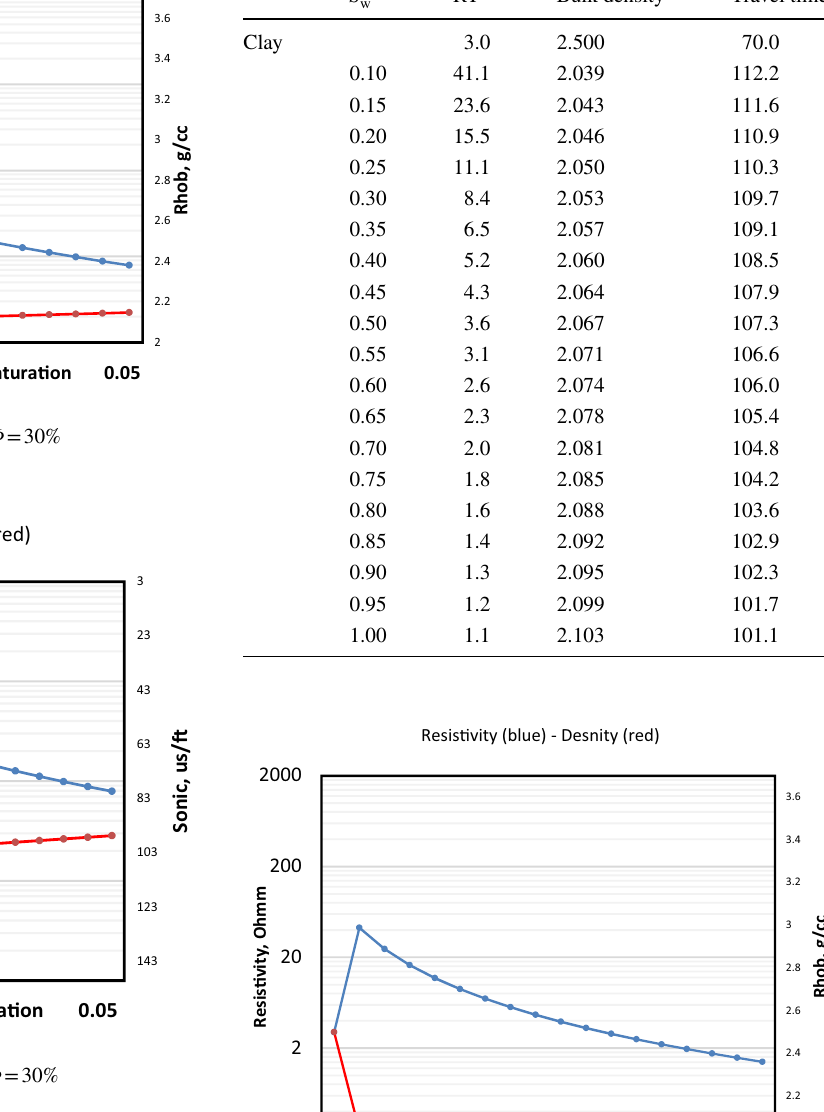
Table 4 Rock responses with, V